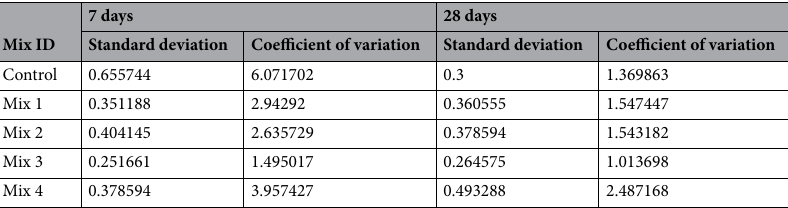
Table 7. Standard deviation and coeffiecient of variation of compressive strength results (MPa).